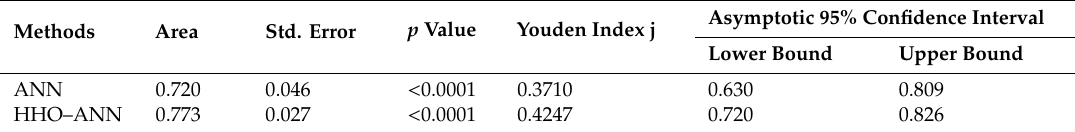
Table 3. The ratio and area of each susceptibility class.